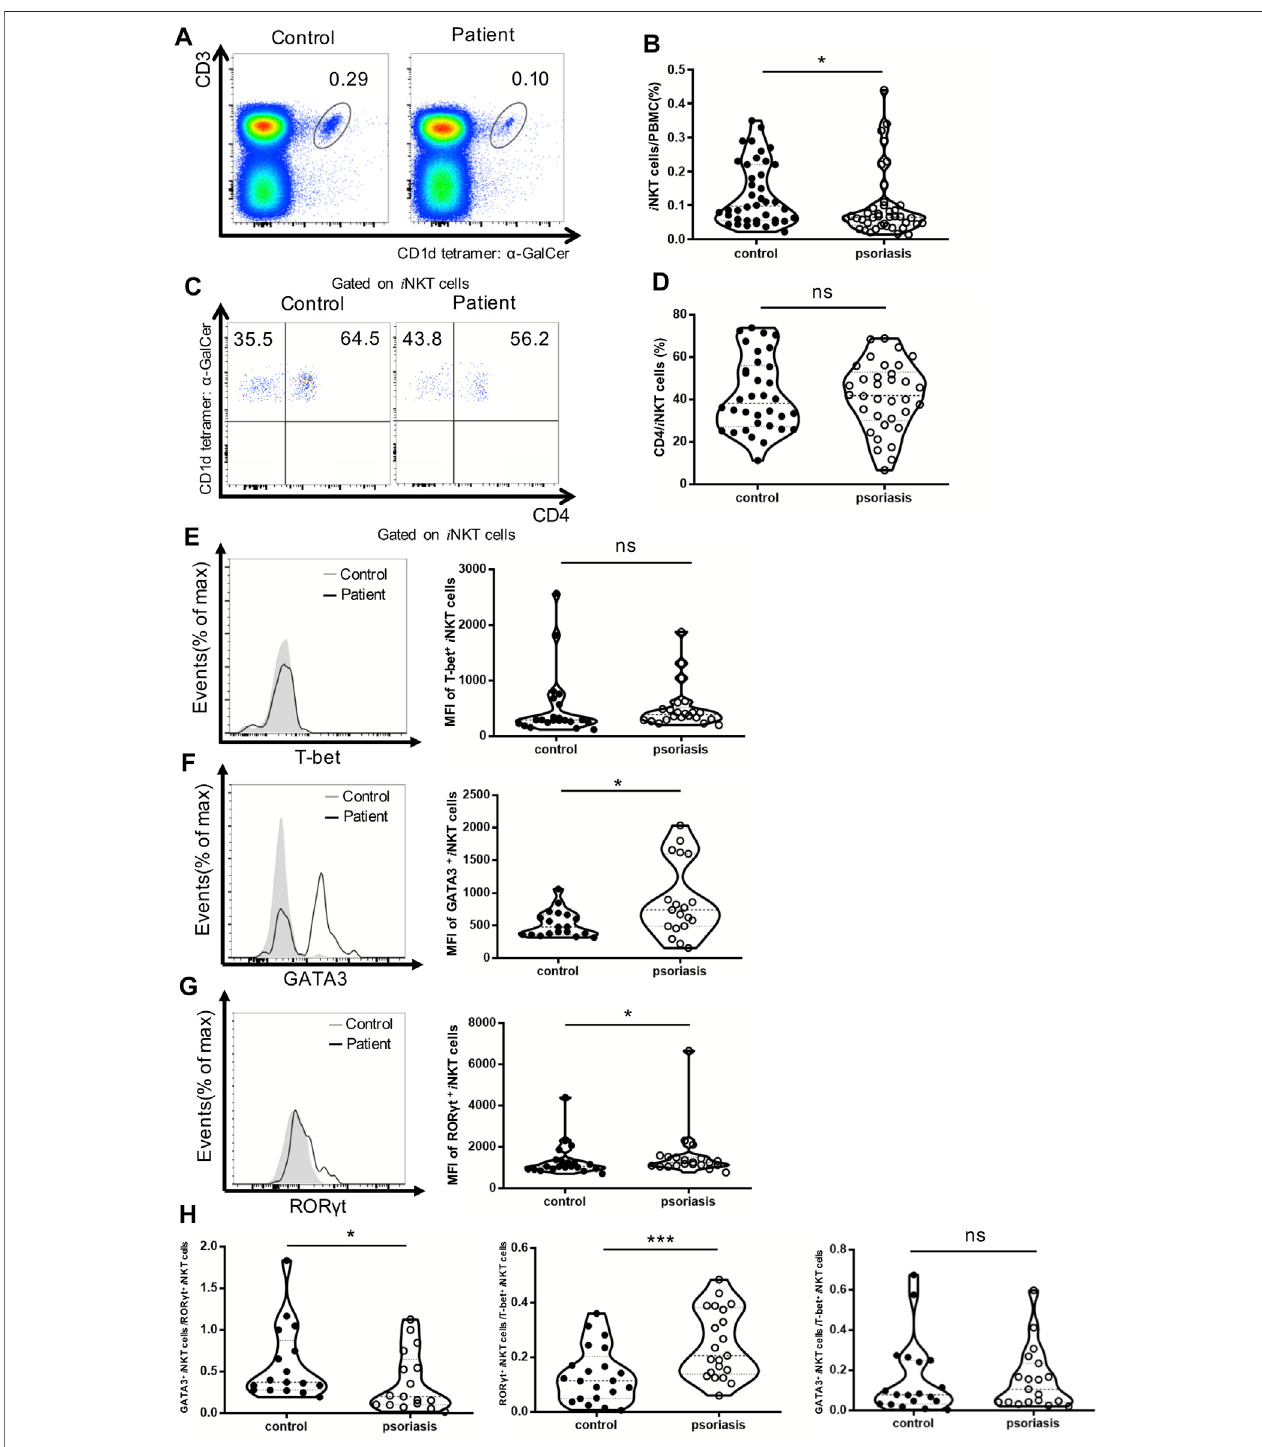
FIGURE 3 | i NKT cells frequency and cell subsets in PBMCs of psoriasis patients. (A) Representative FACS dot plots for iNKT cells from psoriasis patients and healthy controls. (B) Summary plots showing individual results of iNKT cell frequency in psoriasis patients versus healthy controls. (C) Representative FACS dot plots for iNKT cell CD4 expressioninpsoriasispatientsandhealthycontrols. (D) SummaryplotsshowingindividualresultsofthefrequencyofCD4 + iNKTcellsinpsoriasispatientsversushealthycontrols. (E) Representative histogram and summary plots showing individual results of the MFI for T-bet + iNKT cells in psoriasis patients and healthy controls. (F) Representative histogram and summary plotsshowingindividualresultsoftheMFIfor GATA3+iNKTcellsin psoriasis patientsand healthy controls. (G) Representativehistogramand summary plots showing individual results of the MFI for ROR γ t + iNKT cells in psoriasis patients and healthy controls. (H) Summary plots showing individual results of GATA3+ iNKT cells/ ROR γ t + iNKT cells, ROR γ t + iNKT cells/T-bet + iNKT cells and GATA3+ iNKT cells//T-bet + iNKT cells in psoriasis patients versus healthy controls. Data show mean +SEM. p -values were determined by paired Student ’ s t-test. ns, no signi fi cance, * p < 0.05, ** p < 0.01, *** p < 0.001 and **** p < 0.0001.